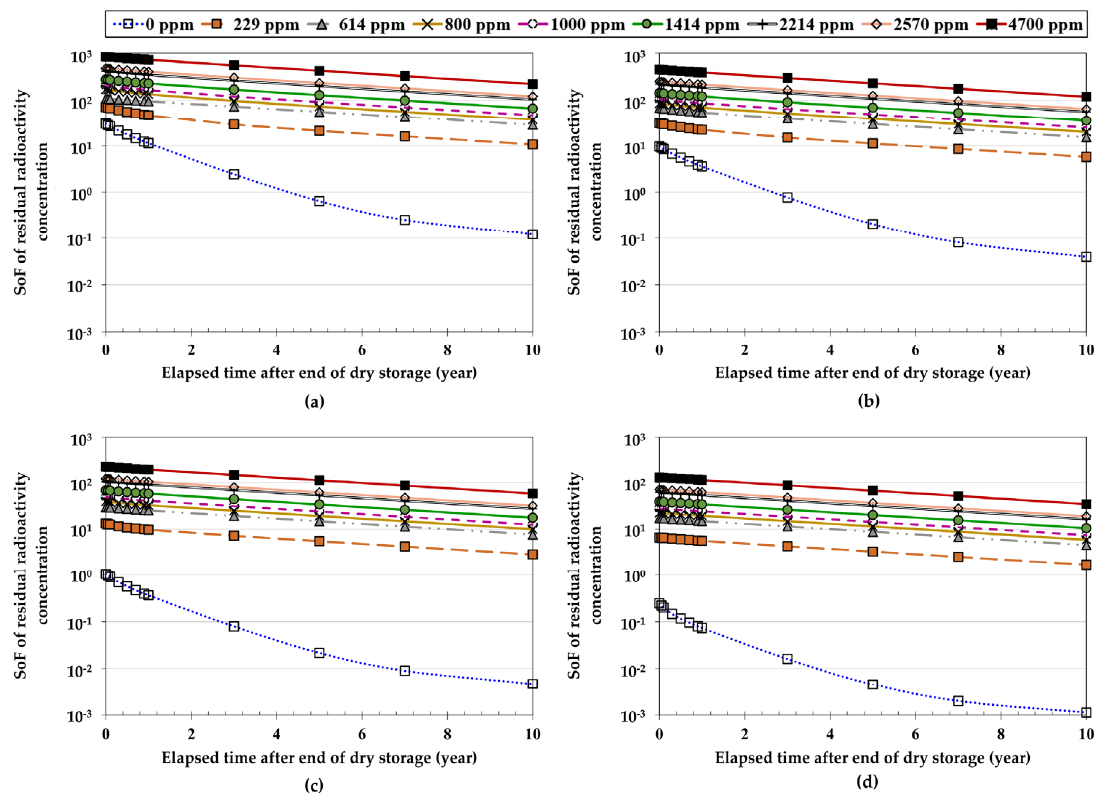
Figure 9. Sum of fractions of the estimated radioactivity concentration to the clearance level of each radionuclide, by varying the 59Co impurity content in SS304 at 0, 229, 614, 800, 1000, 1414, 2214, 2570, and 4700 ppm, for each MPC-24 component: ( a ) basket, ( b ) shell, ( c ) baseplate, and ( d )